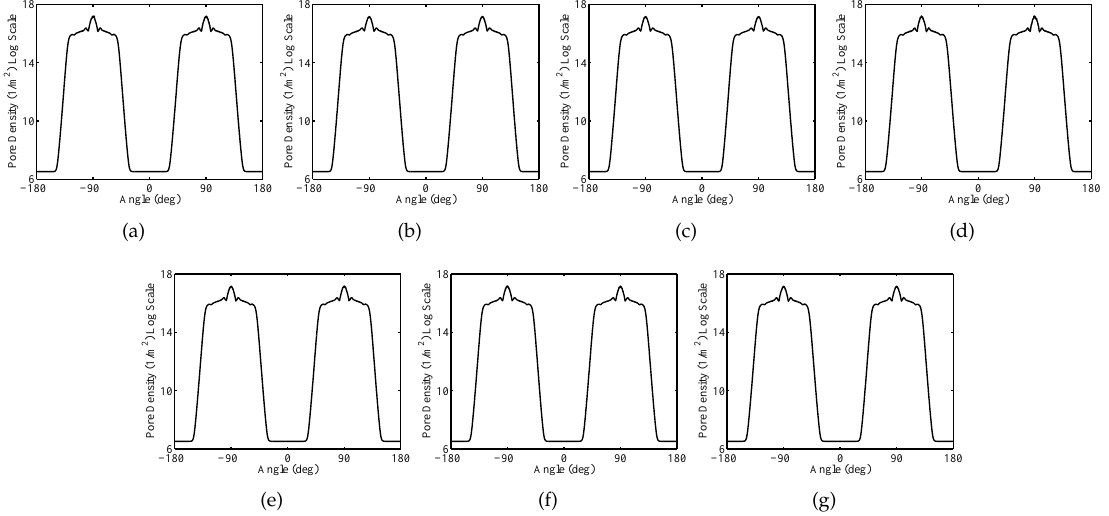
Figure 11. Sparse System—Nuclear membranes (Nm) pore density versus the polar angle at time instant t = 20 ns for cell 1 ( a ), cell 2 ( b ), cell 3 ( c ), cell 4 ( d ), cell 5 ( e ), cell 6 ( f ), cell 7 ( g ).